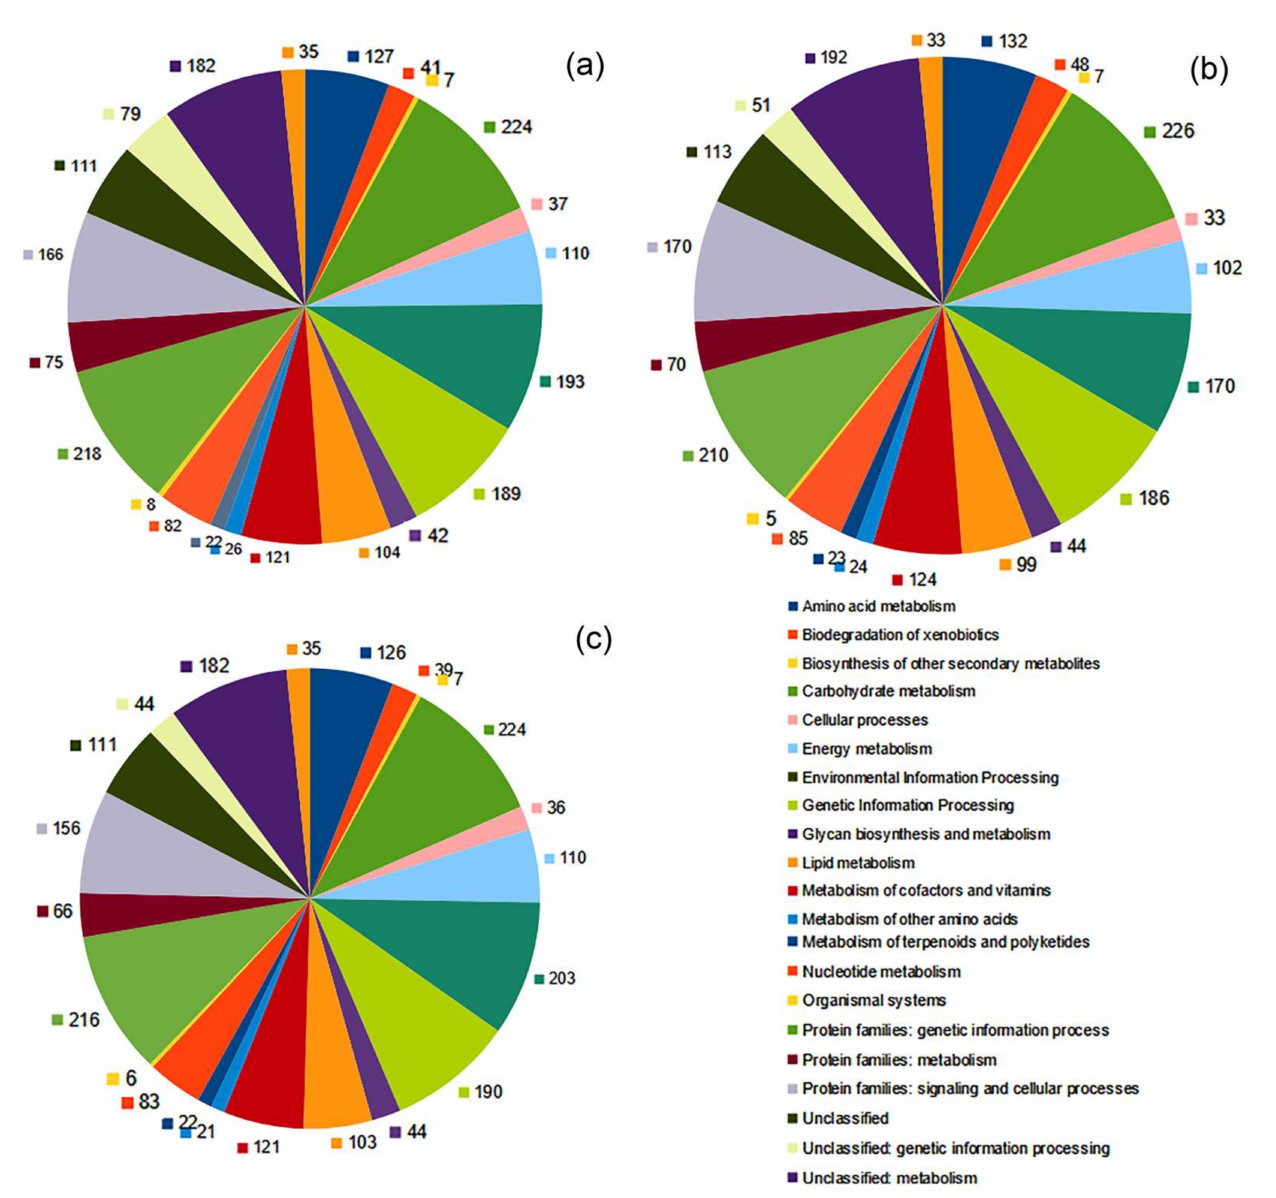
Figure 3. Number of genes associated with general functional categories based on KEGG classification of the chromosomes of strains G. amicalis 6-1 ( a ), G. alkanivorans 135 ( b ), and G. amicalis 1D ( c